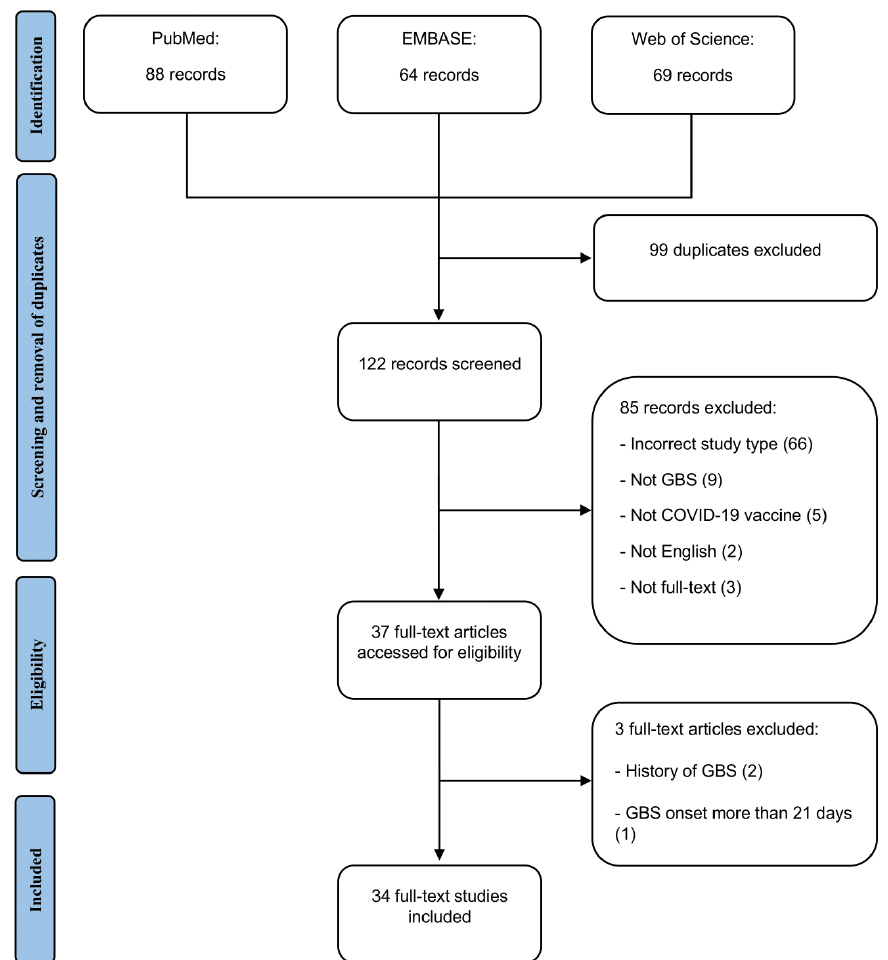
Figure 1. PRISMA flow diagram of search and selection process. GBS: Guillain–Barré Syndrome; COVID-19: coronavirus disease 2019.